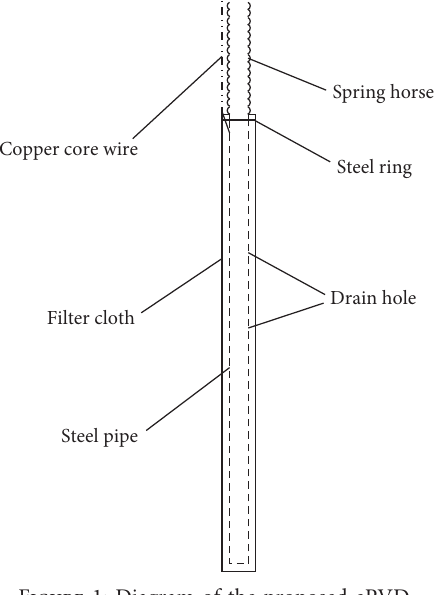
Figure 1: Diagram of the proposed